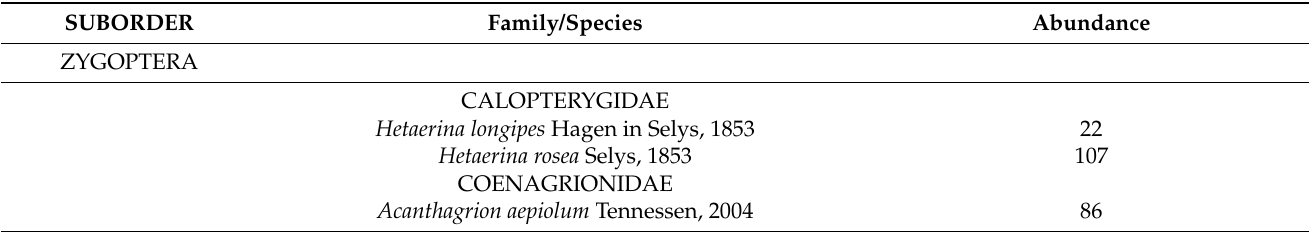
Table A3. Species recorded in the cacao areas, in the streams sampled in the southern region of